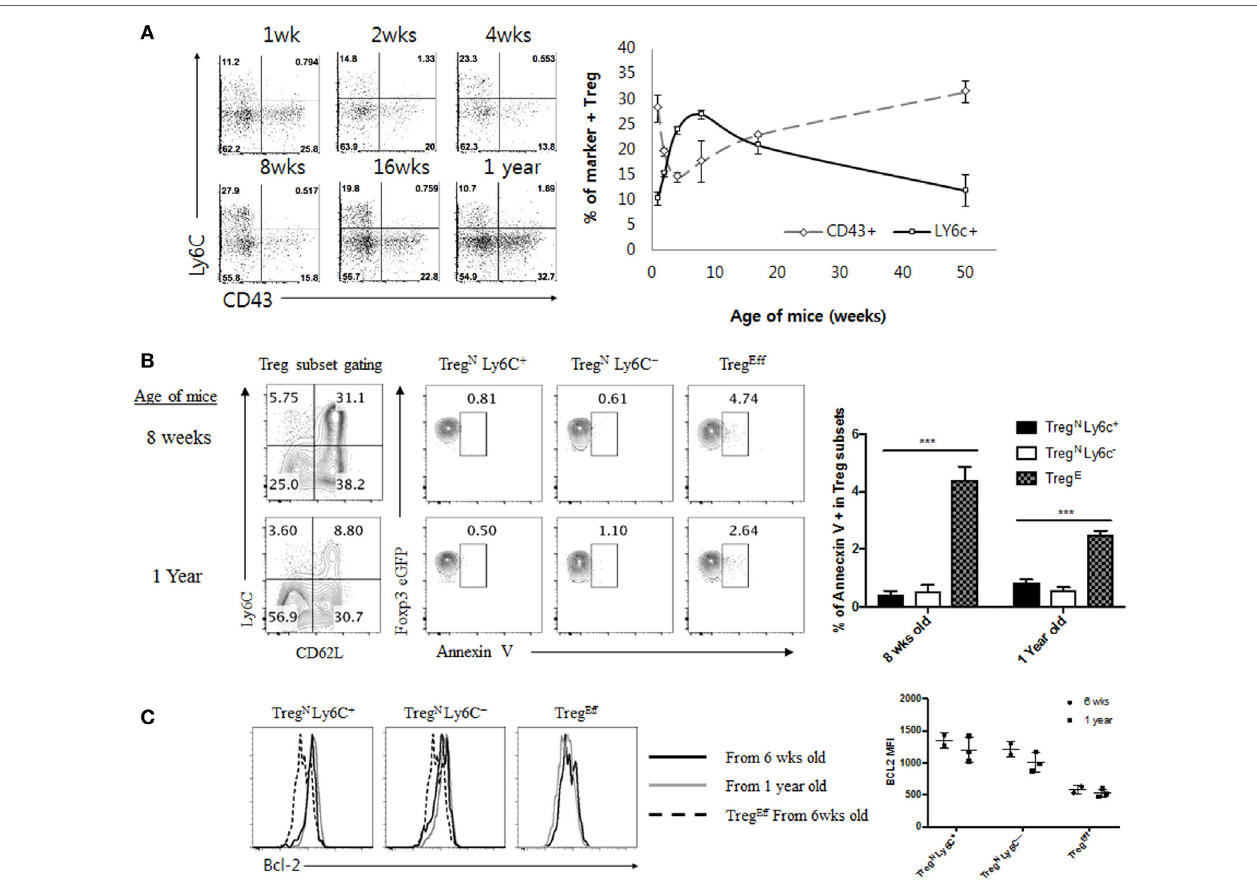
FigUre 4 | Age-dependent disappearance of Treg N Ly6C + is not correlated with increased apoptosis in aged mice. (a) Peripheral lymph node cells from Foxp3- eGFP mice of various ages indicated were stained with CD43, CD4, Ly6C, and PI. Shown are CD43 and Ly6C expression on CD4 + eGFP + cells (left) and statistics (right). (B) T regulatory (Treg) subsets from young (8 weeks) or aged (1 year) mice Foxp3-eGFP mice were stained with Annexin V, CD4, PI, Ly6C, and CD62L. Shown are gated on PI − CD4 + eGFP + Treg (top left) and then gated on indicated markers. (c) Treg subsets from young (8 weeks) or aged (1 year) mice Foxp3-eGFP mice were analyzed for Bcl-2 expression. The data are representative of three experiments comprising two to three mice per group. * p < 0.05, ** p < 0.01, and *** p <